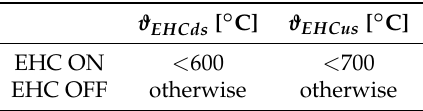
Table 2. Criteria for EHC